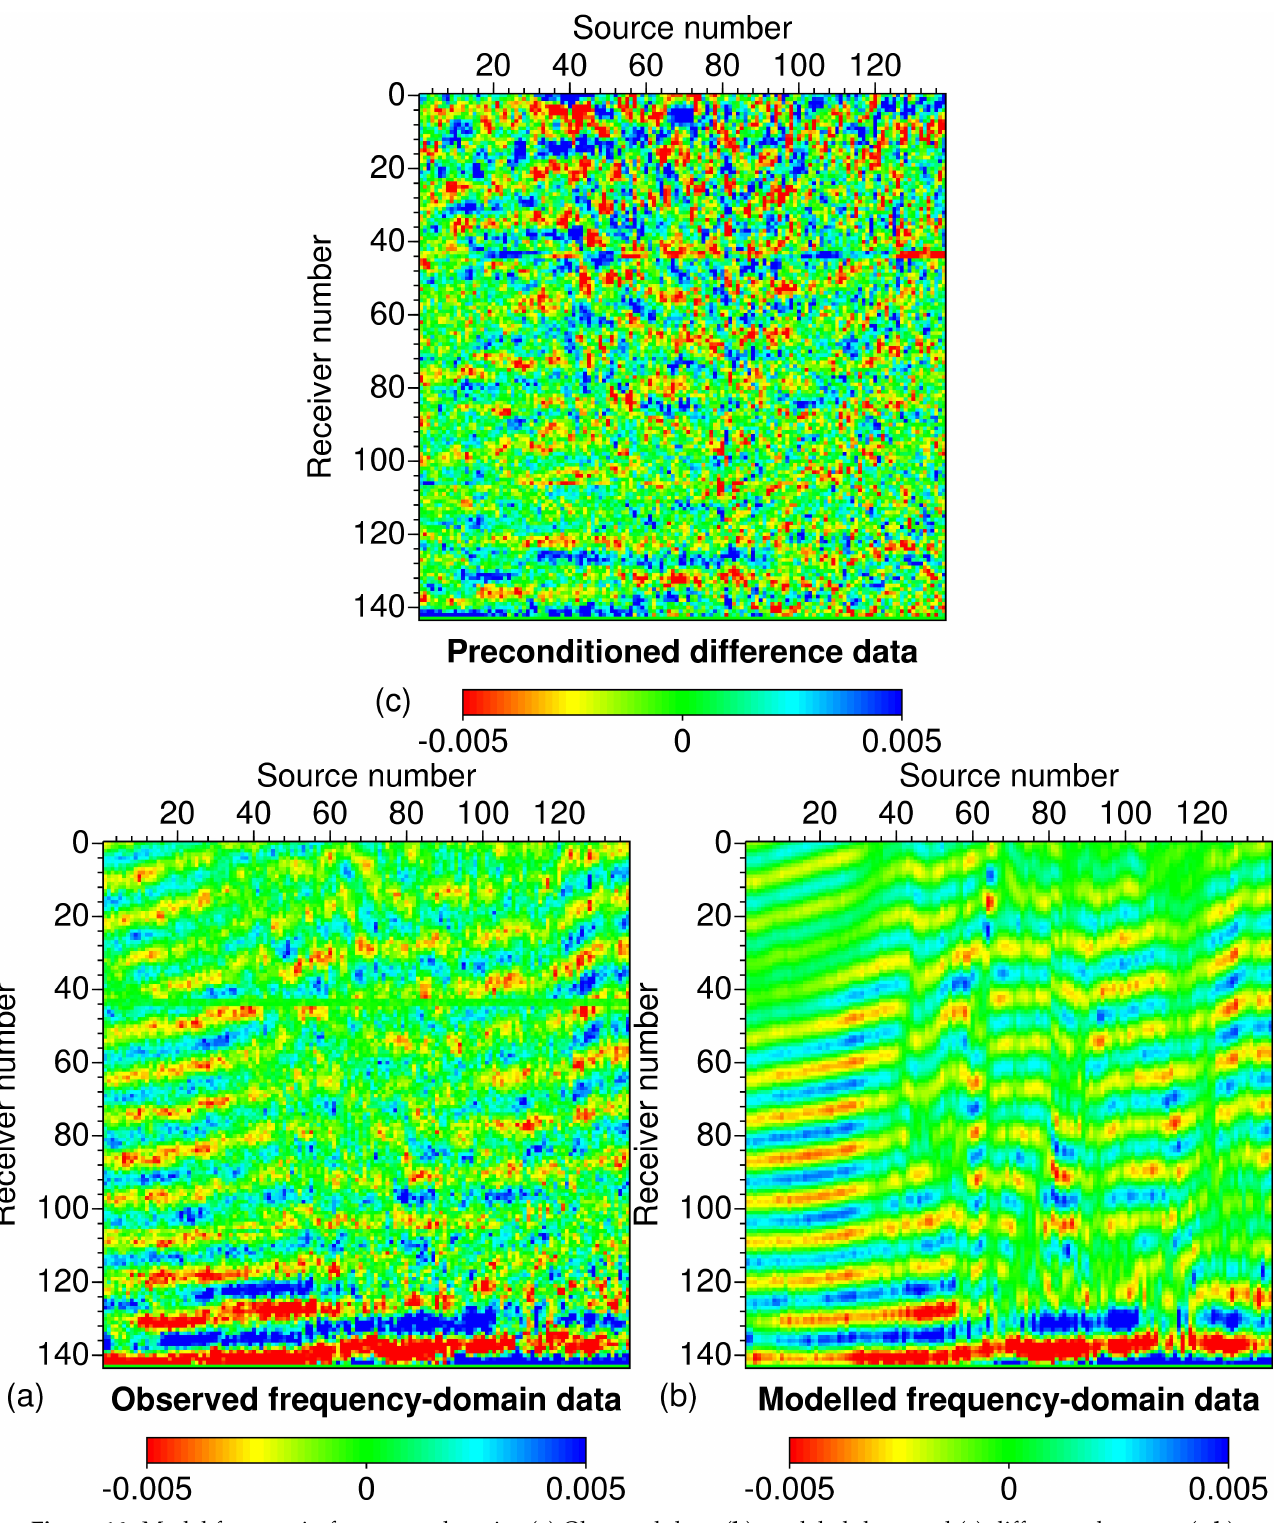
Figure 16. Model features in frequency domain. ( a ) Observed data, ( b ) modeled data, and ( c ) difference between ( a , b ) corresponding to a frequency of 6 Hz. Note that small receiver numbers correspond to the far-offset